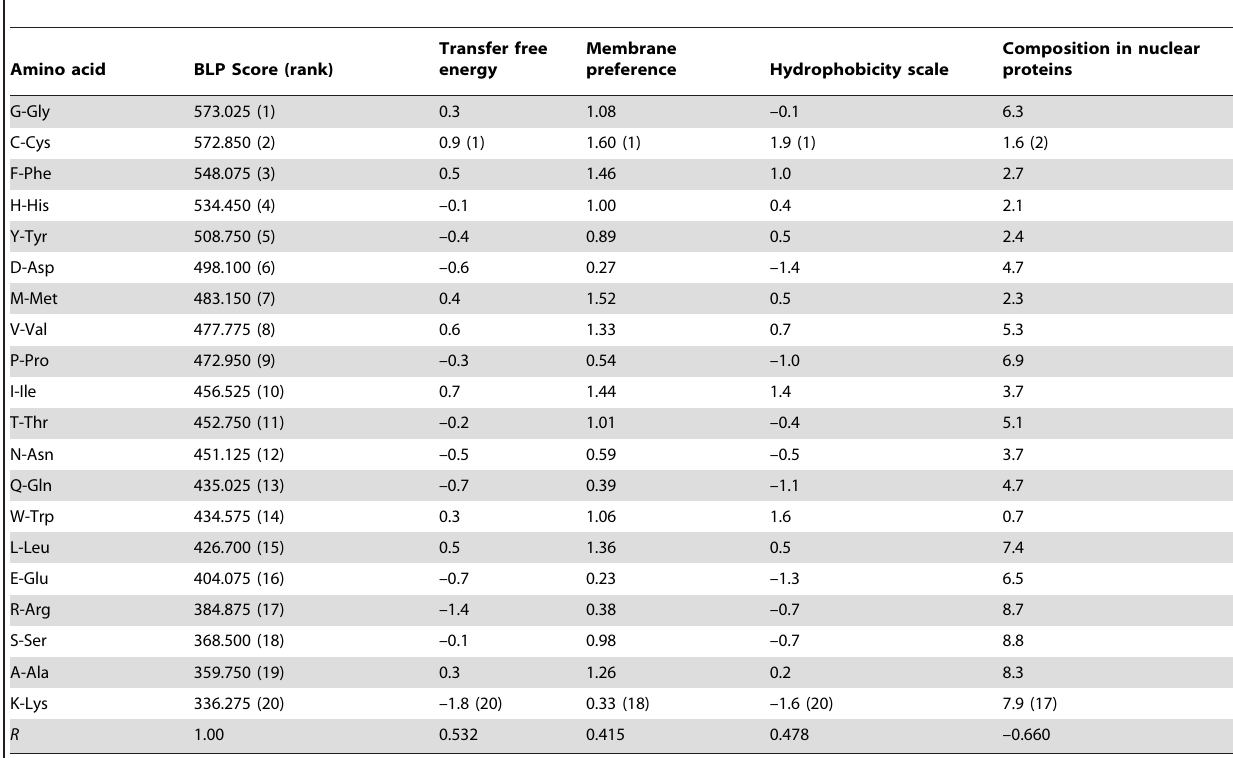
Table 4. The propensity scores of amino acids to be a bioluminescent protein (BLP) and four physicochemical properties of amino acids with Pearson’s correlation coefficient (the R